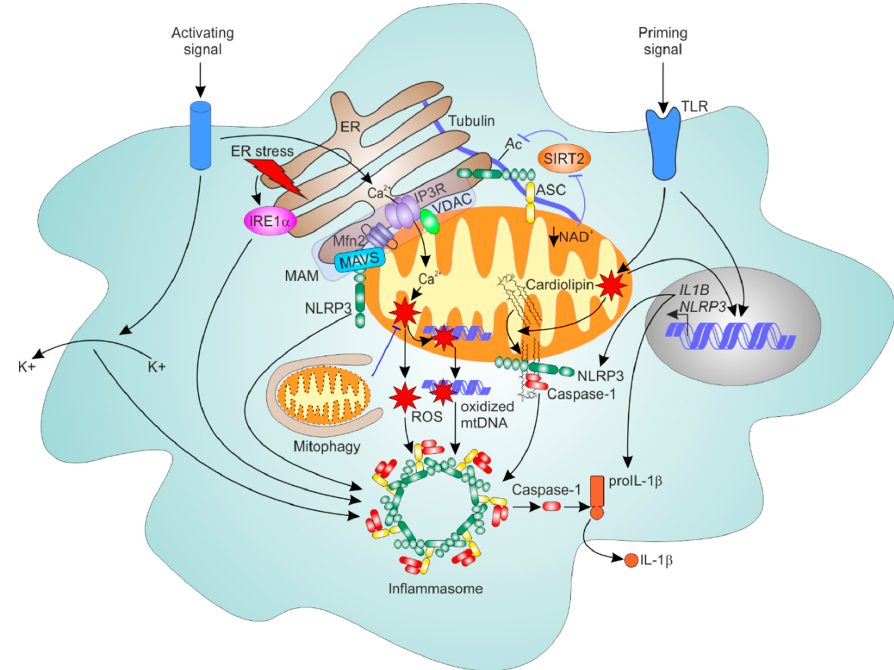
Figure 2. ER-mitochondrial communication in NOD-like receptor protein 3 (NLRP3) inflammasome regulation. NLRP3 inflammasome activation requires two signals; a priming signal (e.g. toll-like receptor (TLR) activation) induces the expression of pro-IL-1 β and NLRP3, which occurs in a mROS-dependent manner. Priming signals also induce mROS-dependent cardiolipin translocation to the outer mitochondrial membrane (OMM), where it recruits NLRP3 and caspase-1. An